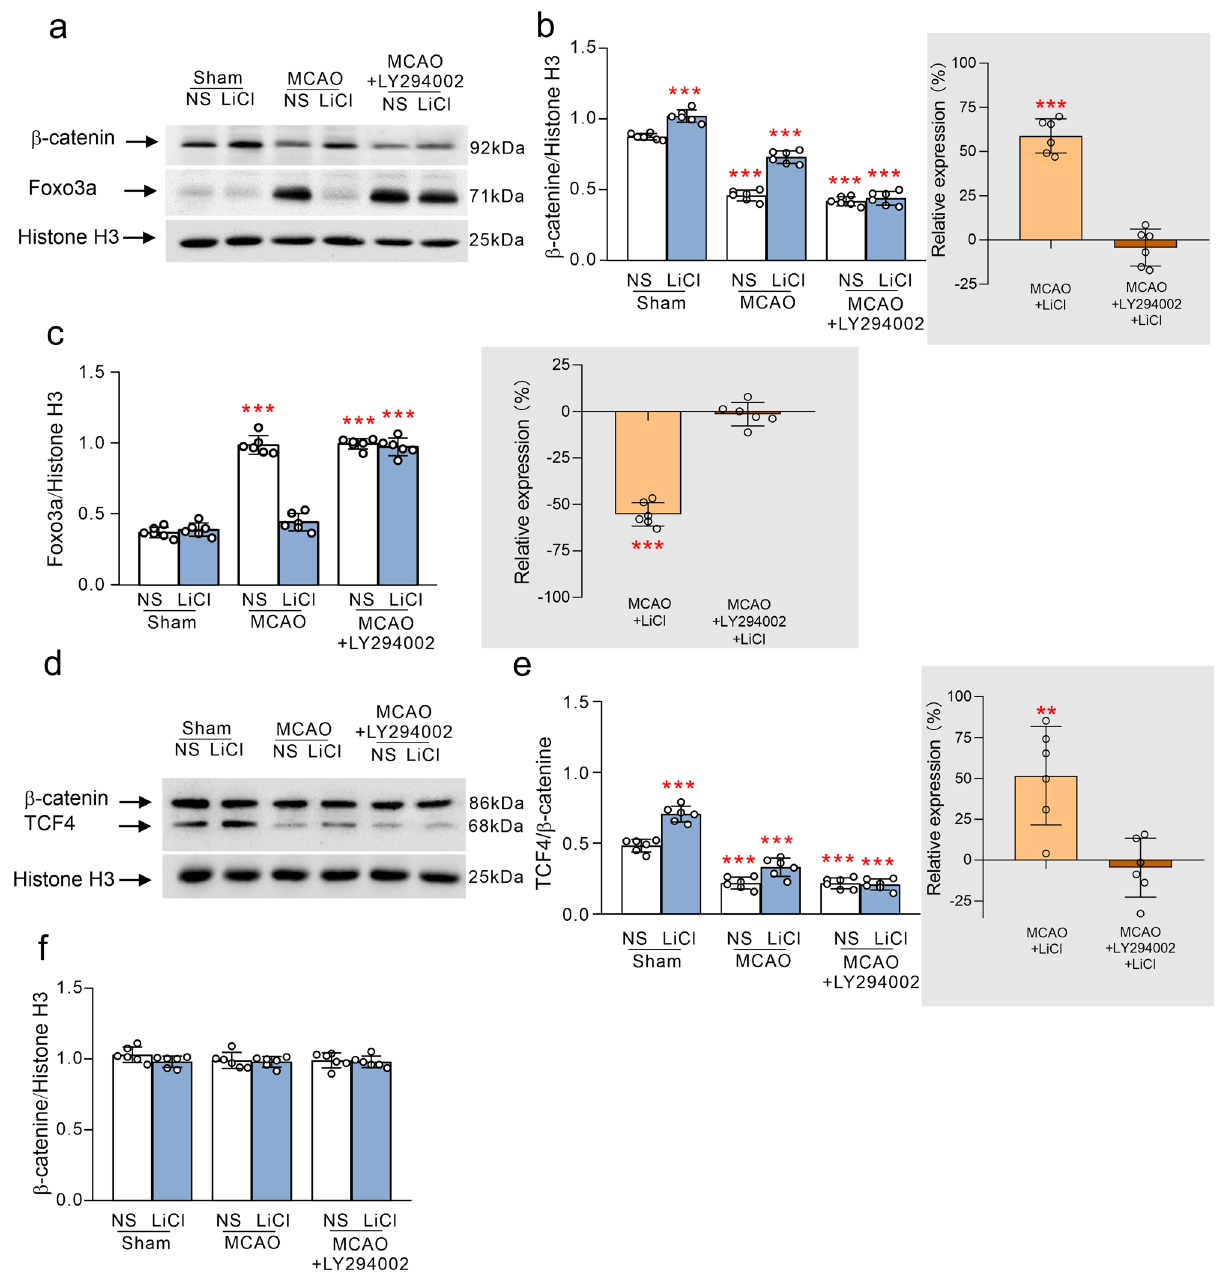
Fig. 4 The effects of Li + in the nuclear levels of β -catenin, FoxO3a and TCF4 by stimulating AKT following ischaemia-reperfusion. a The representative protein bands of β -catenin, FoxO3a and Histone H3 (the house-keeping protein) in nucleus. The normalised intensities of β -catenin and FoxO3a by Histone H3 were shown in b and c , inserts on the right are the relative comparison with the respective MCAO groups. d The representative protein bands of β -catenin, TCF4 and Histone-H3 (the house-keeping protein) in nucleus. The binding ratio of TCF4 with β -catenin is shown in e , and the normalised intensities of Histone H3 by β -actin are shown in f , the right insert shows comparison with the respective MCAO groups. The protein levels were calculated and plotted as mean ± SD. N = 6 per group. Two-way ANOVA for comparisons including more than two groups; unpaired two-tailed t -test for two group comparisons. * p < 0.05, ** p < 0.01, *** p <